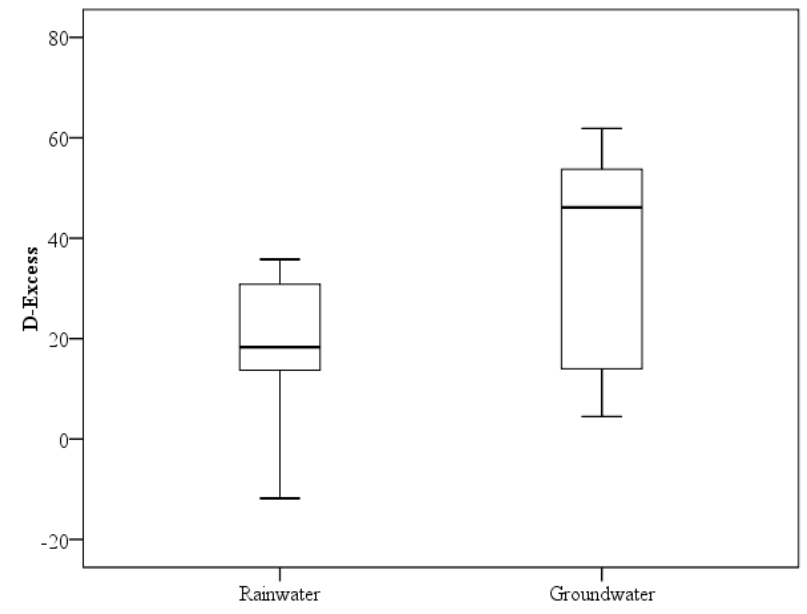
Figure 4. Box-and-whisker plots showing the d-excess values of rainwater and groundwater.